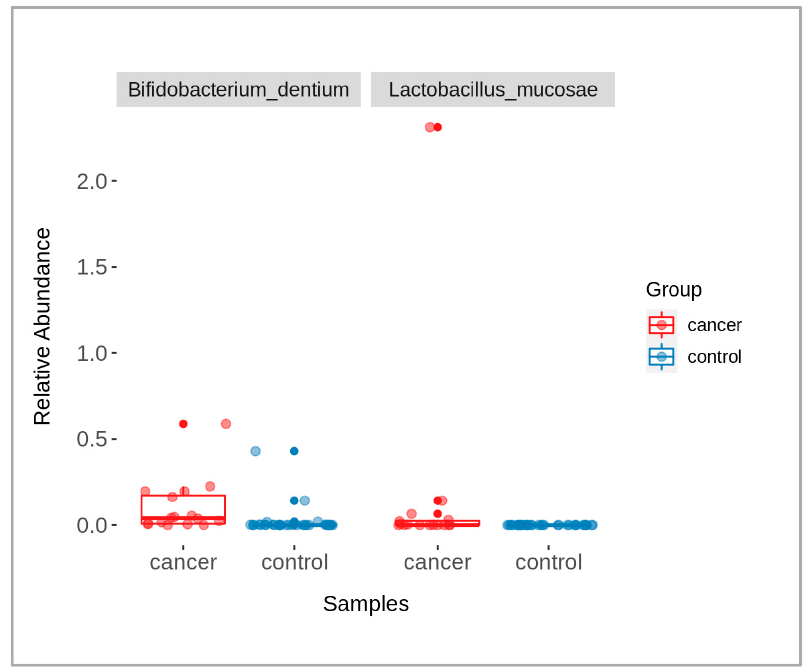
Figure 3. A box-plot showing the presence of significantly different bacterial taxa between cancer (red) and control (blue) groups ( p -value < 0.05).